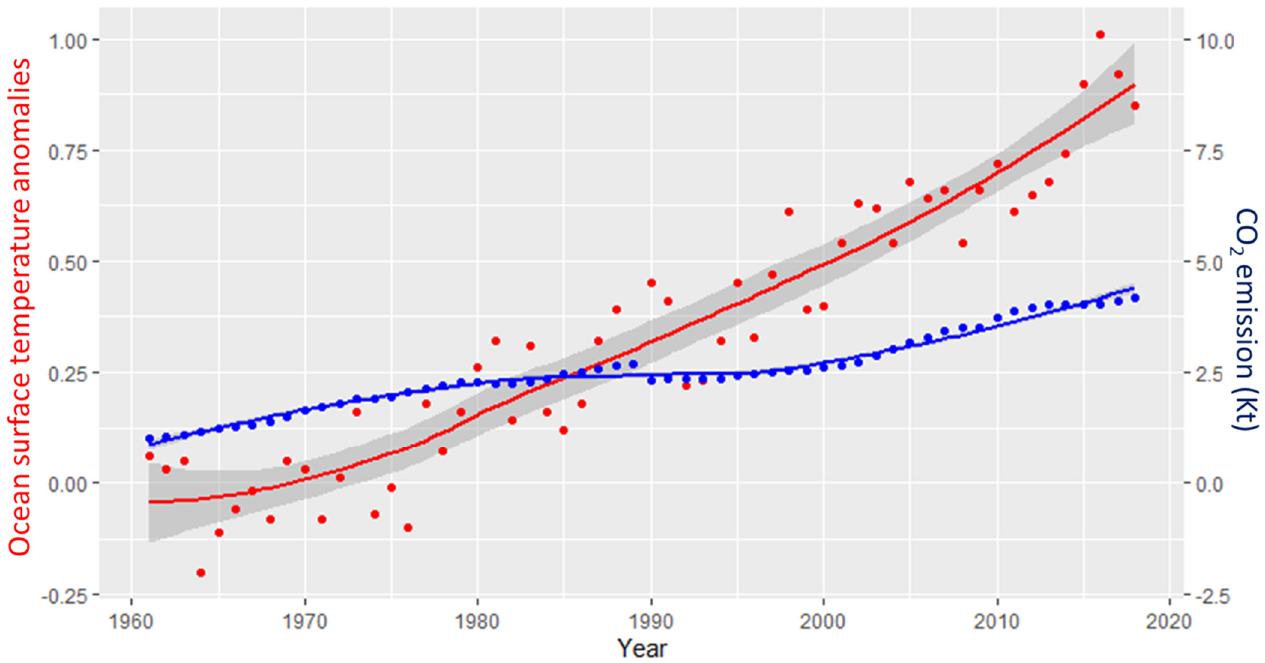
Figure 4. Annual atmospheric carbon dioxide (CO 2 ) emissions (blue) and annual ocean surface temperature anomalies (red) over the last six decades. Annual anomalies in ocean surface temperature data were retrieved from the National Oceanic and Atmospheric Administration [26], and CO 2 emis- sions data were retrieved from the Global Carbon Project Source link [19].